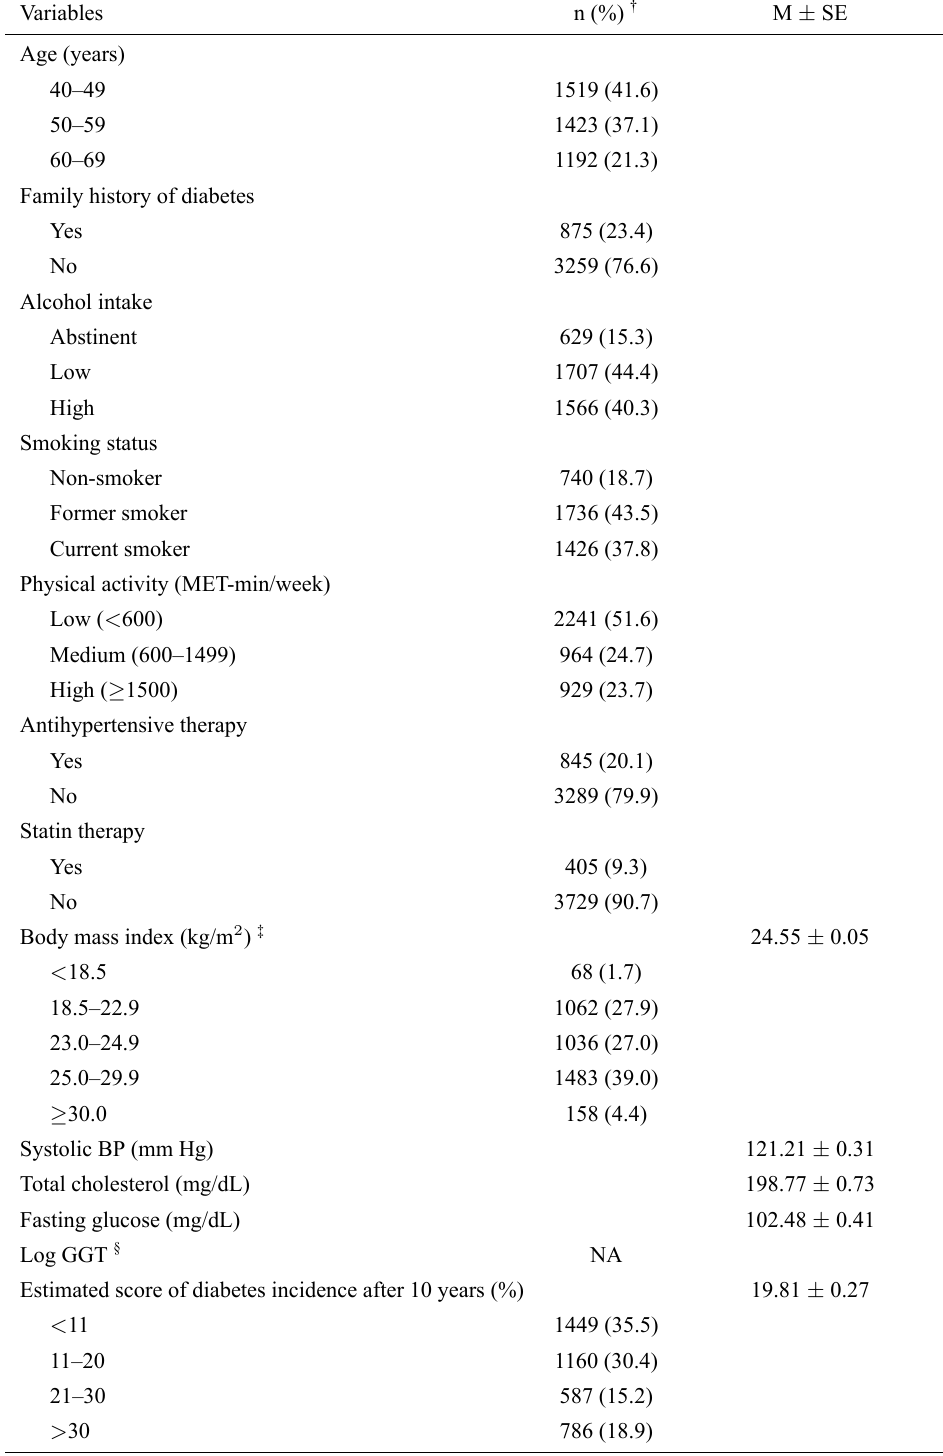
Table 2. Ten-year estimated incidence of type 2 diabetes mellitus in adult male Korean subjects (N = 4134).